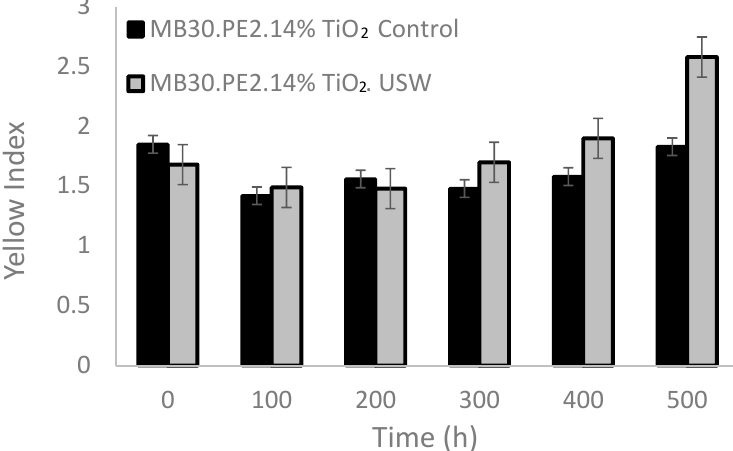
Figure 6. Effect of standard extrusion vs. ultrasound-extrusion on the yellowness index of films pigmented with TiO 2 at 7 wt%.